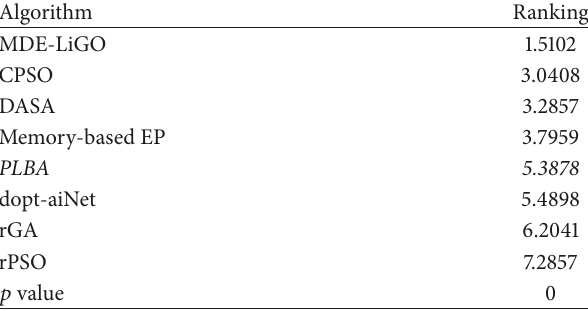
Table 14: Average rankings of PLBA and other algorithms (Fried- man) on dynamic benchmark problems 𝐹 1 – 𝐹 6 in terms of the solution